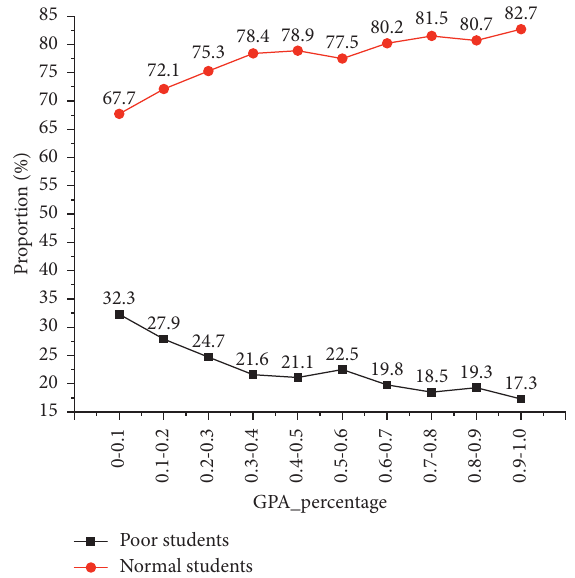
Figure 5: Proportion of poor students in different GPA rankings.